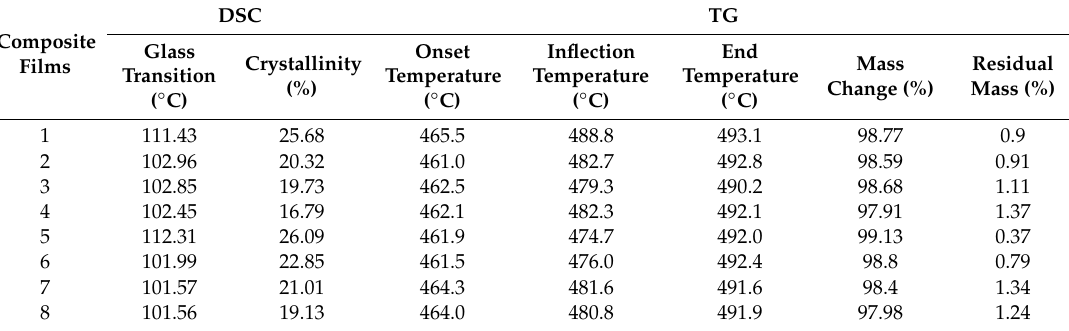
Table 2. Di ff erential scanning calorimetry (DSC) and thermogravimetric (TG) analysis of eight di ff erent specimens.